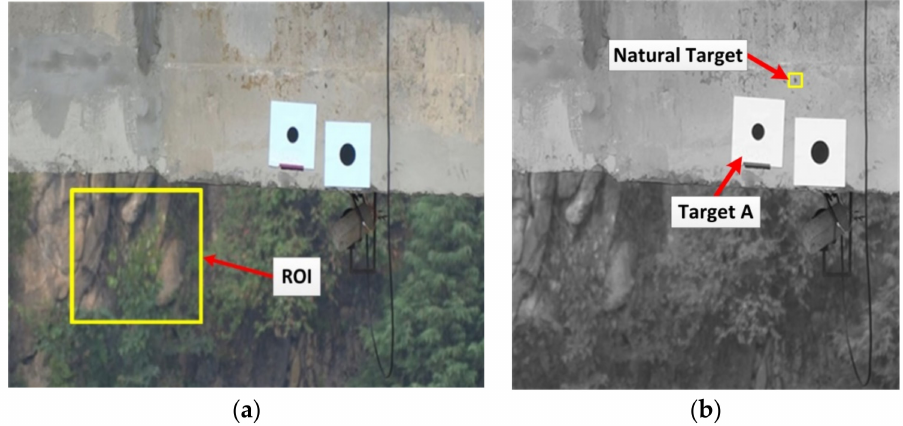
Figure 12. Image global motion correction: ( a ) specifying ROI for motion parameter estimation; ( b ) generated corrected